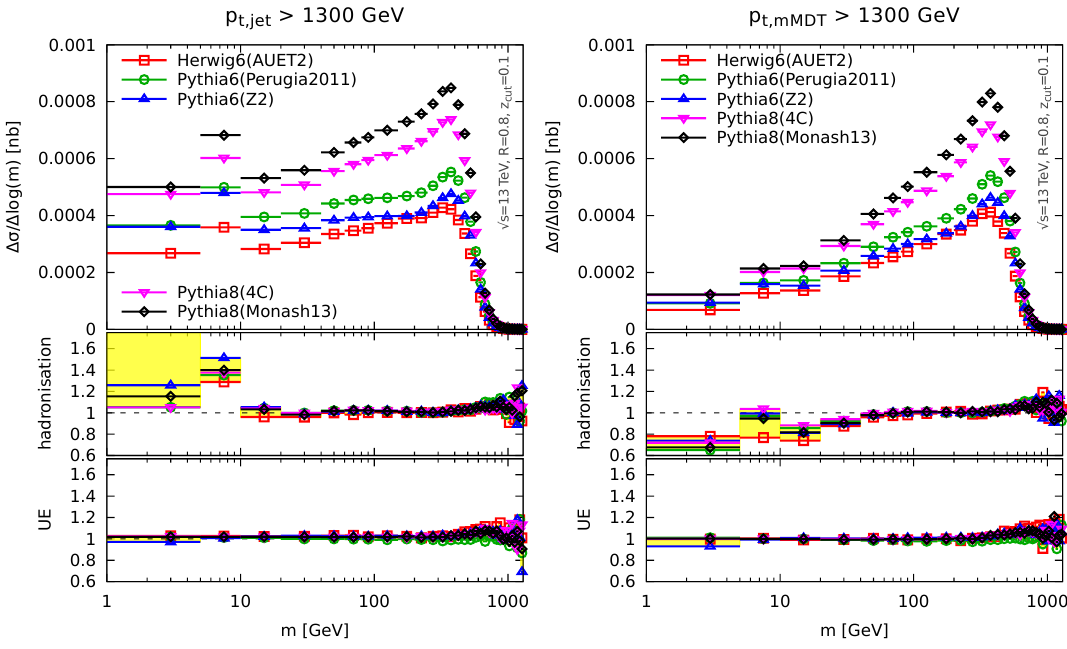
Figure 10 . Same as (cid:12)gure 9 but for the bin p t > 1300 GeV.